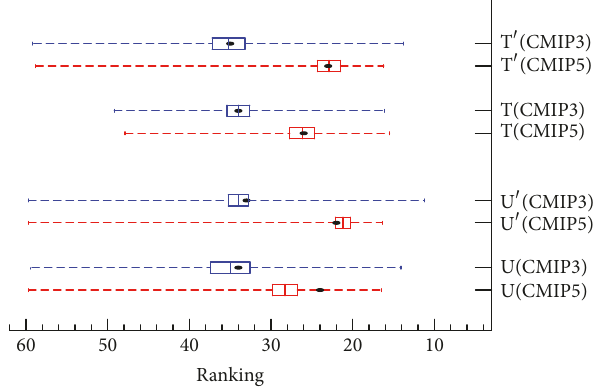
Figure 4: Similar to Figure 3 but for the temporal rankings. The primes represent rankings with the 30-year means removed from each grid.